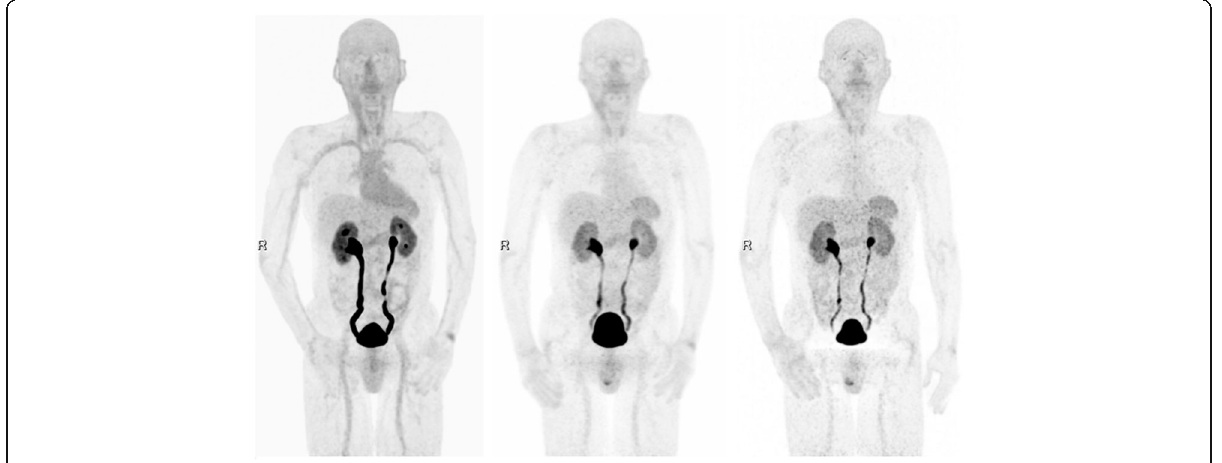
Fig. 1 From l eft to right , example of maximum intensity projections 10, 60 and 120 min post tracer injection showing 68 Ga-NODAGA-RGDyK uptake distribution in major abdominal organs. In this patient case, retention of radio-urine in the excretory system is exacerbated by prostatic